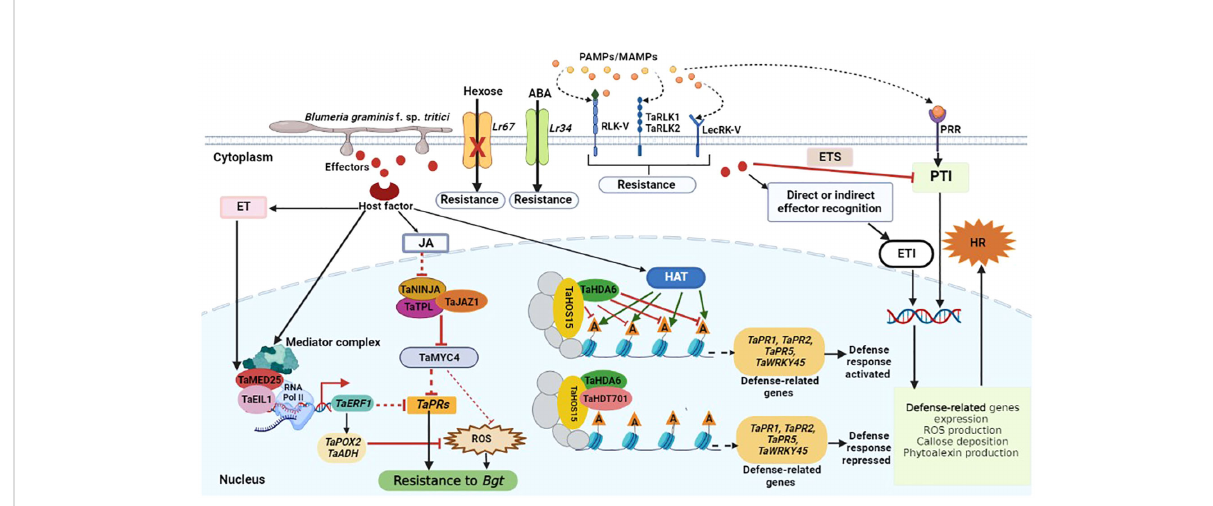
FIGURE 1 Schematic representation of wheat defense responses to Bgt infection. Pathogen-derived conserved molecules (PAMPs/MAMPs) are recognized by pattern recognition receptors (PRRs), and this activates PAMP-triggered immunity (PTI). Pathogens induce susceptibility by interfering with the immune signaling network through the secretion of effectors, resulting in effector-triggered susceptibility (ETS). Following direct or indirect effector recognition, plant R proteins activate host defense responses to inhibit pathogen growth, and this is called effector-triggered immunity (ETI). The receptor-like kinases ( TaRLK1 , TaRLK2 ), malectin-like/LRR-RLK ( RLK-V ), and lectin type RLK ( LecRK-V ) resistance genes, encode proteins that are involved in the perception of fungal determinants and transmission of defense signals to the cell interior. Upon Bgt , reactive oxygen species (ROS) and endogenous pathogenesis-related ( PR ) genes are highly induced to enhance defense response to infection. Meanwhile, the physical interaction between TaMED25 and TaEIL1 may lead to the recruitment of RNA Pol II to enhance the transcription of TaERF1. TaERF1 may further suppress ROS accumulation and the expression of PR genes to partially attenuate wheat basal resistance to Bgt infection. TaJAZ1, TaNINJA and TaTPL form a co-repressor complex that suppresses TaMYC4 transcriptional activity under normal conditions. Jasmonate (JA) accumulation in response to Bgt infection results in the degradation of TaJAZ1 to release TaMYC4 and other transcriptional factors, consequently leading to the suppression of TaPRs expression and ROS accumulation in wheat. Ethylene (ET) also inhibits ROS accumulation and the expression of TaPRs to negatively regulate wheat resistance against Bgt infection. Furthermore, Bgt infection also results in the recruitment of more histone acetyltransferases (HATs) and thus increase histone acetylation at the defense related genes (represented by green arrows), thus activating the expression of these genes. The TaHDT701-TaHDA6-TaHOS15 histone deacetylase complex mediates histone deacetylation at the wheat defense-related genes like TaPR1 , TaPR2 , TaPR5 and TaWRKY45 , which results in the suppression of defense-related genes transcription and defense responses to Bgt